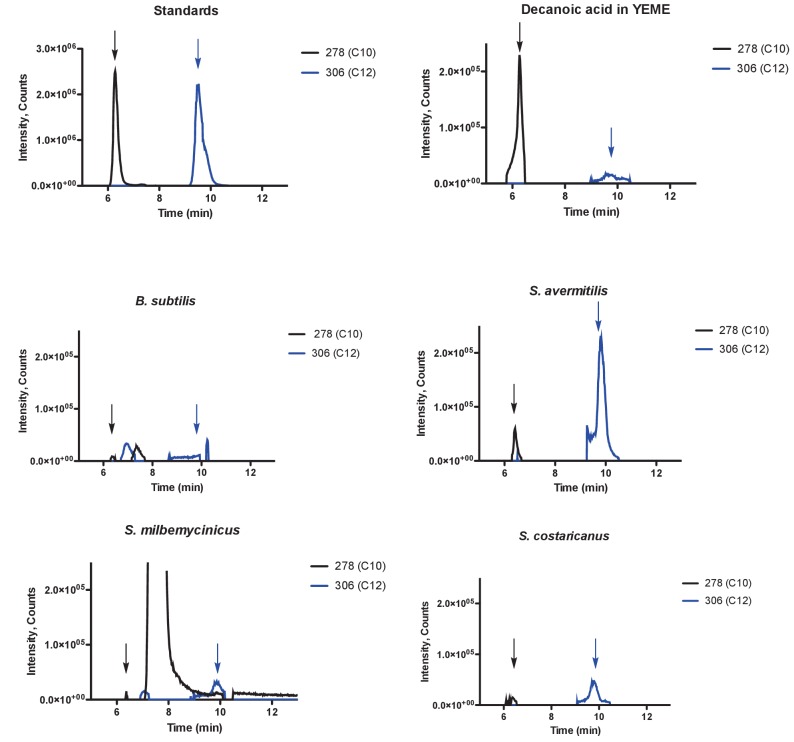
Dodecanoic acid is secreted by Streptomyces.Modified decanoic (C10) and dodecanoic (C12) acids were detected by LC-MS by searching for molecular weights of 278 and 306 g/mol, respectively. Modified decanoic (C10) and dodecanoic (C12) acid standards, decanoic acid in YEME control, B. subtilis control, S. avermitilis, S. milbemycinicus, and S. costaricanus are shown. Arrows point to decanoic and dodecanoic acid retention times.